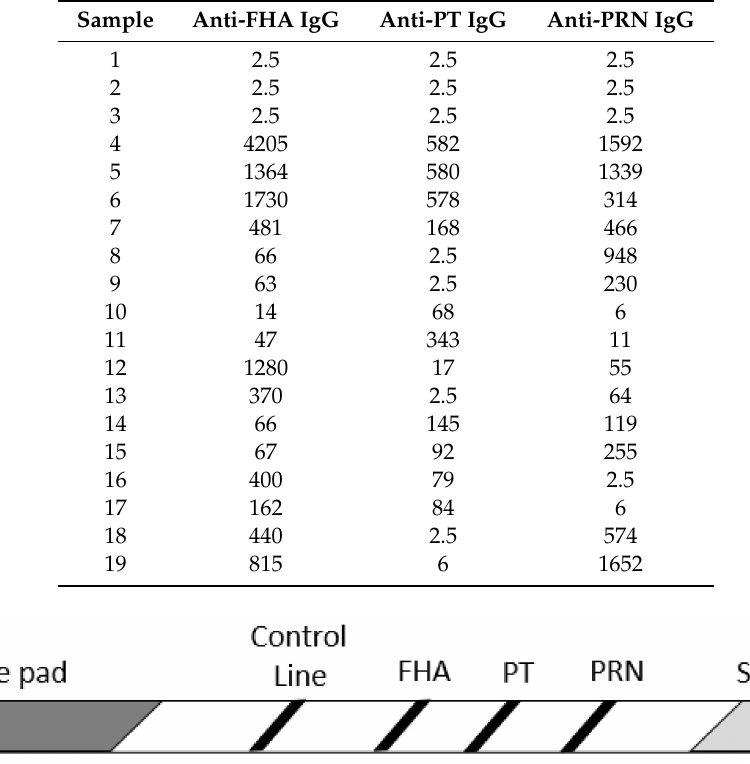
Table 1. Study samples with known concentrations of anti-PT, –PRN and –FHA IgG antibodies (ELISA units / mL).